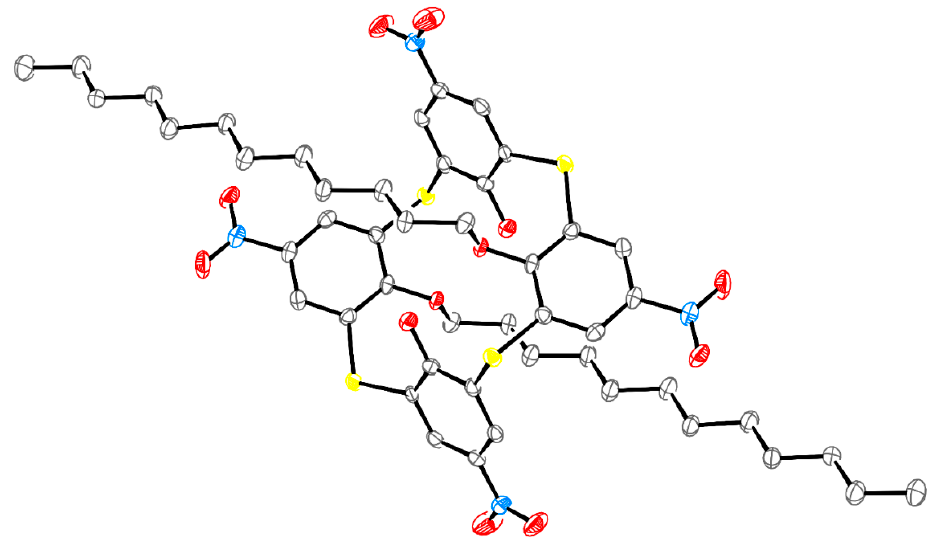
Figure 4. ORTEP projection of compound 2a in the crystals at 70% probability level. Non-hydrogen atoms are omitted for clarity.